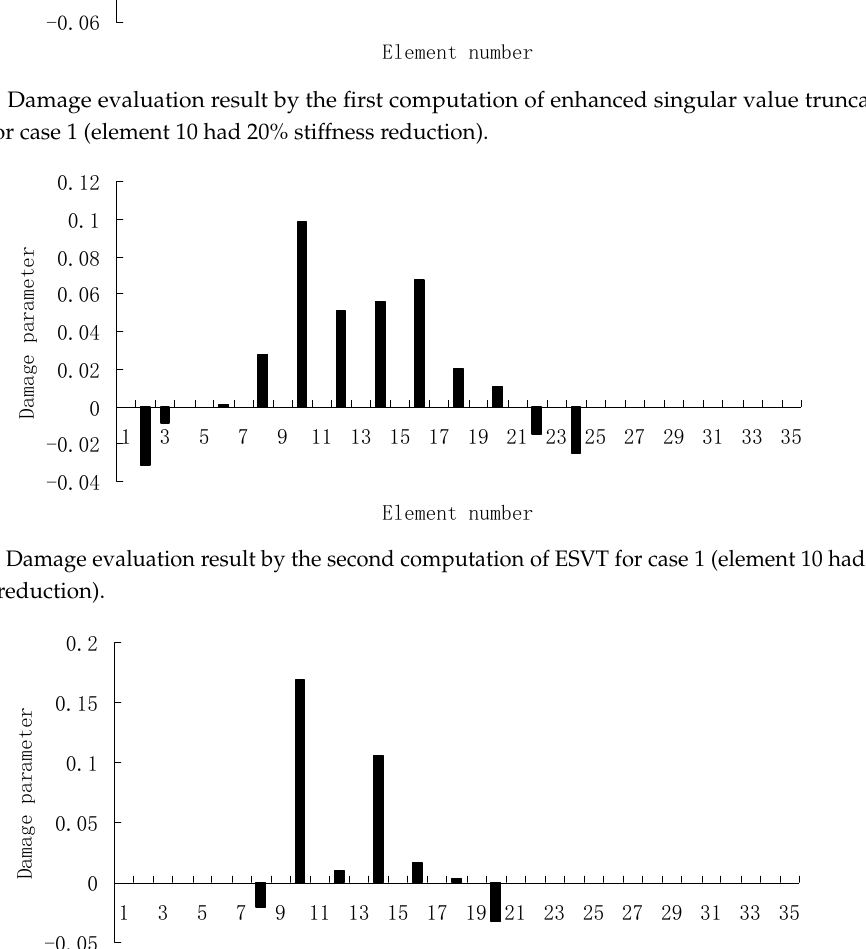
Figure 6. Damage evaluation result by the third computation of ESVT for case 1 (element 10 had 20% stiffness reduction).